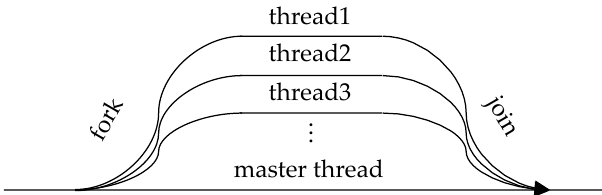
Figure 5. A sketch of the OpenMP fork-join